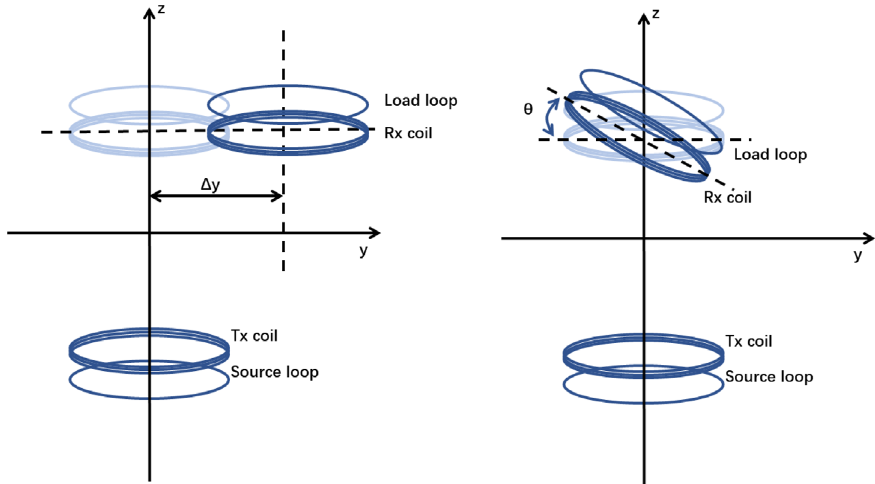
Fig. 5. Possible deviation between transmitting and receiving coils.